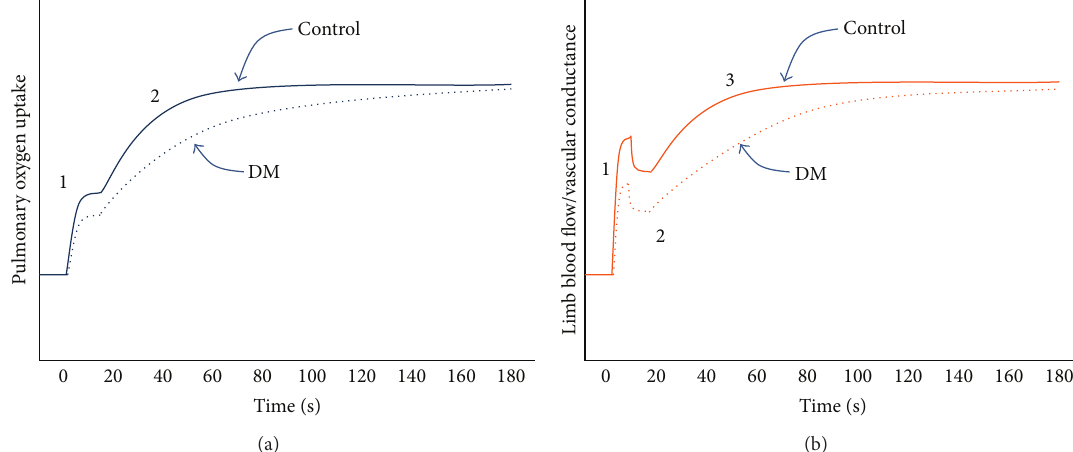
Figure 2: (a) Effect of type 2 diabetes mellitus (DM) on the dynamic response of pulmonary oxygen uptake during submaximal exercise below the ventilatory threshold. DM blunts the cardiodynamic phase (“1”) and slows the rise (increases the time constant) of the primary phase (“2”). Note that a third phase (“slow component”) is observed at higher intensities and can also be observed in a minority of subjects below the ventilatory threshold, but the effect of DM on this phase is not clear. (b) Effect of DM on the dynamic response of limb blood flow and vascular conductance during submaximal contractions (calf muscle). DM blunts the fast growth phase (“1”), has minimal effect on the rapid decay phase (“2”), and slows the rise (increases the time constant) of the slow growth phase (“3”). Note that a fourth phase, a slow decay, is observed in some subjects but it is not shown in this figure and the effect of DM on it is not